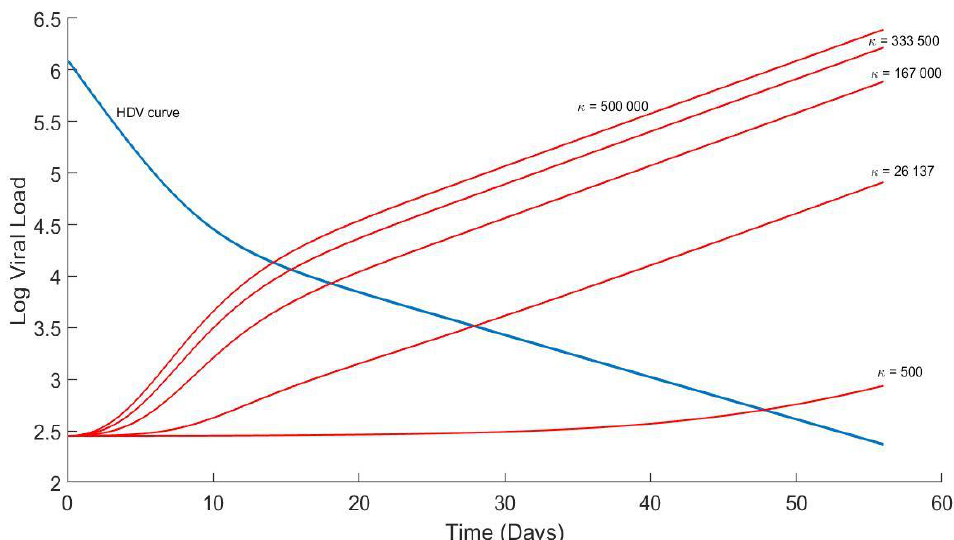
Figure 3. One-way sensitivity analysis on the impact of parameter κ on predicted HBV kinetics, B, (red curves) under anti-HDV treatment. Model parameters were set to D 0 = 1 , 202 , 260, B 0 = 282, c = 0.47, n = 1.25, g = 0.094, τ = 0.1, and ε = 0.97. HDV predicted kinetics, D (blue curve) was not affected by different κ values.